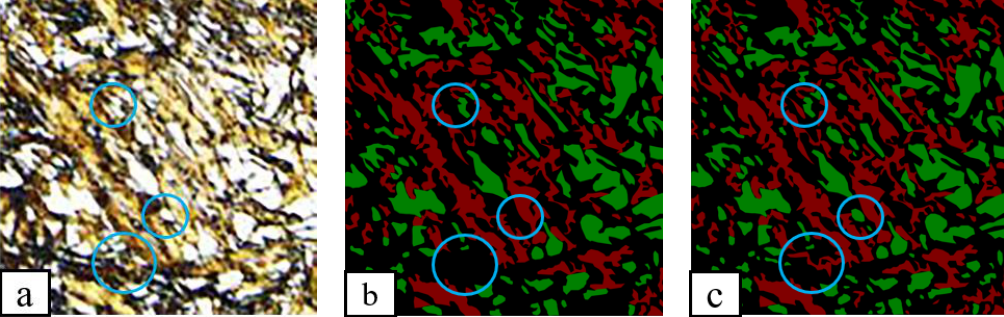
Figure 5. ( a ) Original image; ( b ) segmented image without the improved network model; ( c ) segmented image with the improved network model.